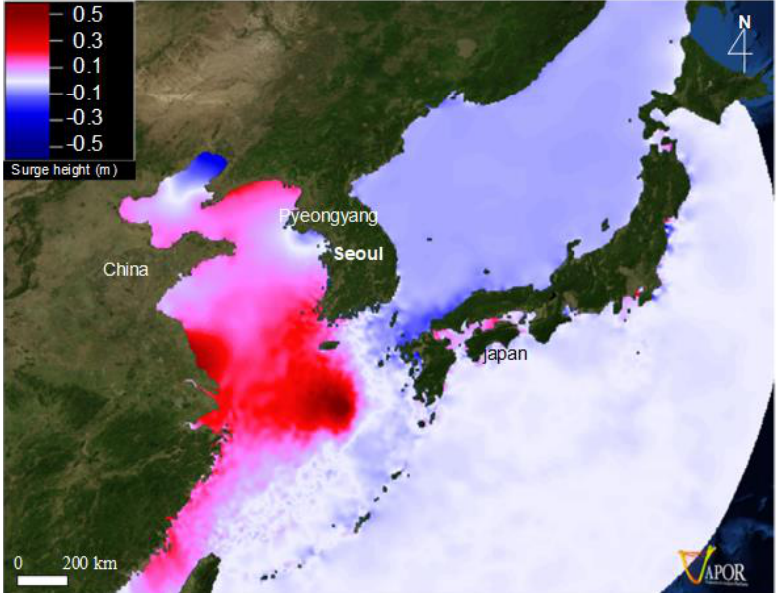
Figure 7. Visualization of storm surge height around South Korea .